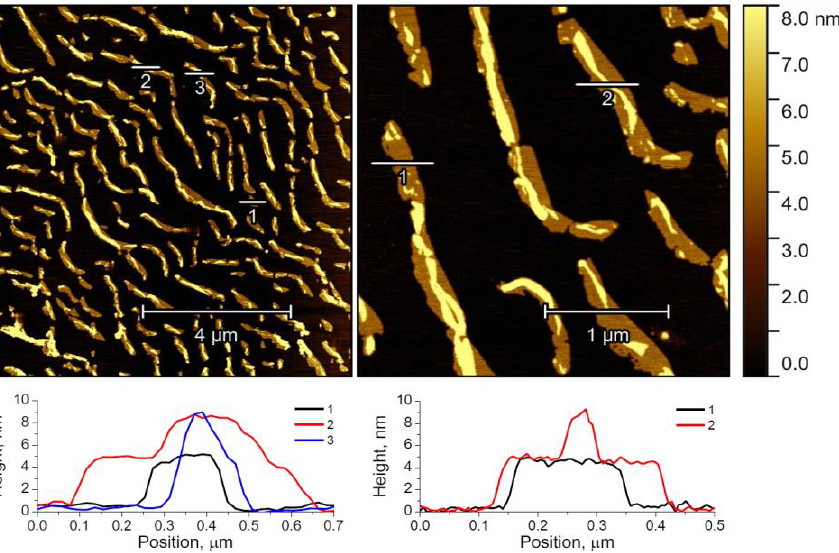
Figure 6. AFM images of one-layer LS film of QC8 deposited onto a mica substrate at a surface pressure of 20 mN m − 1 from the deionized water surface and corresponding height profiles. The numbers 1 – 3 in the graph legends correspond to the regions shown in the images.